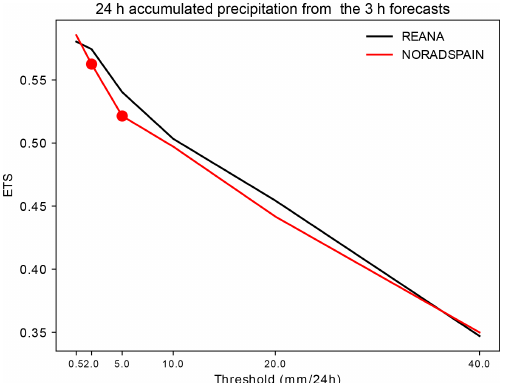
Figure 14. Equitable threat score (ETS) for the 24h accumu- lated precipitation from the 6 to 30h forecast ranges initialized at 00:00UTC each day of the period from 5 September to 5 Novem- ber 2012 computed over the AROME-WMED domain with rain gauges of the HyMeX database (version 4). Results for REANA are displayed in black, and those for NORADSPAIN are in red. Dots indicate that the difference between the curves is statistically sig- nificant.